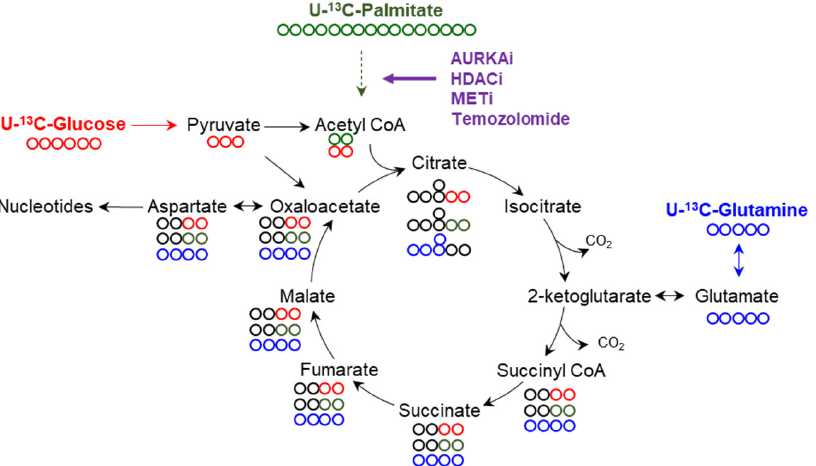
Figure 2. The tricarboxylic acid cycle is fueled by several major sources including glucose, glutamine, and palmitic acid. During glycolysis, glucose (containing six carbons) reacts to 2 molecules of pyruvate. Pyruvate reacts either to oxaloacetate (pyruvate carboxylase reaction) or is oxidized to acetyl-CoA. Acetyl-CoA reacts with oxaloacetate to citrate. Palmitic acid (U-C13) is oxidized (beta-oxidation) and the final product is acetyl-CoA as well. It is noteworthy that both uniformly labeled glucose and palmitic acid result in the m+2 citrate isotopologue (originating from m+2 acetyl-CoA). The carboxylation reaction (pyruvate to oxaloacetate) results in m+3 labeled citrate (not shown). U-13C-Glutamine gives rise to the m+5 alpha-ketoglutarate isotopologue (anaplerotic reaction) and in turn is oxidized in the TCA-cycle. HDAC, aurora kinase A, MET inhibitors, and temozolomide facilitate beta oxidation, enhance anaplerosis through the pyruvate carboxylase reaction, and dampen glutamine